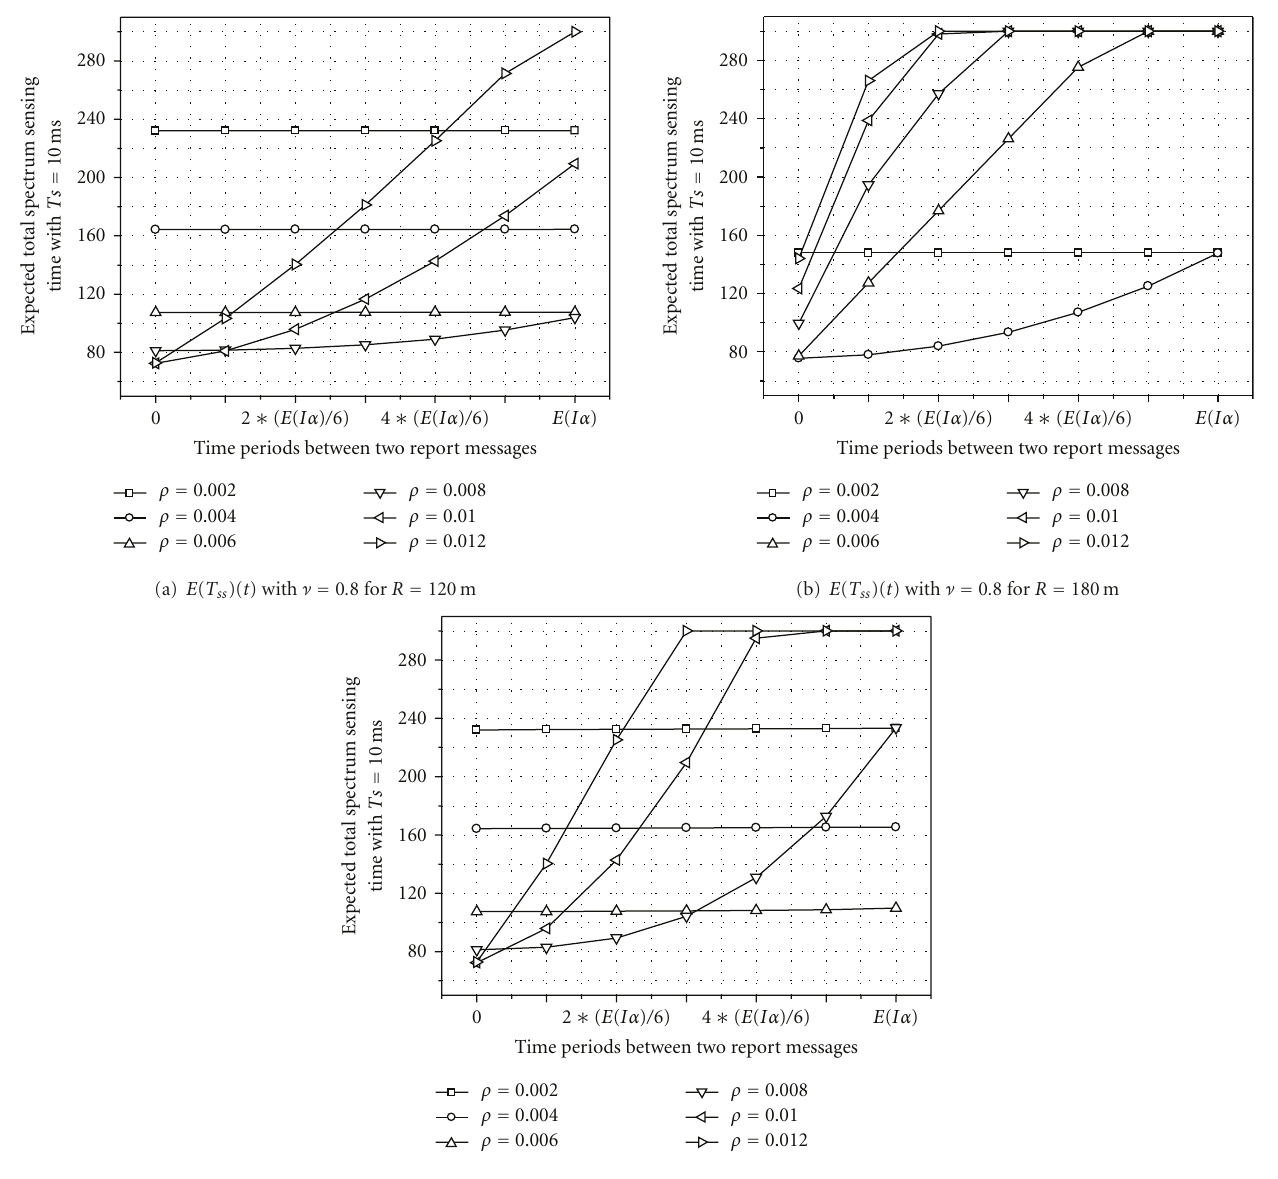
Figure 7: With the spectrum sensing reliability index, R s = 0 . 9, the analysis results of the expected spectrum sensing time, E ( T ss )( t ), with N = 30 are presented. Subfigure (b) is the analysis results of E ( T ss )( t ) for R = 180 m. Three subfigures depict that E ( T ss )( t ) rather steeply increases when ρ becomes greater than a saturation point. In subfigure (c), with a lower ν = 0 . 4, E ( T ss )( t ) still could be reduced significantly when ρ is less than or equal to